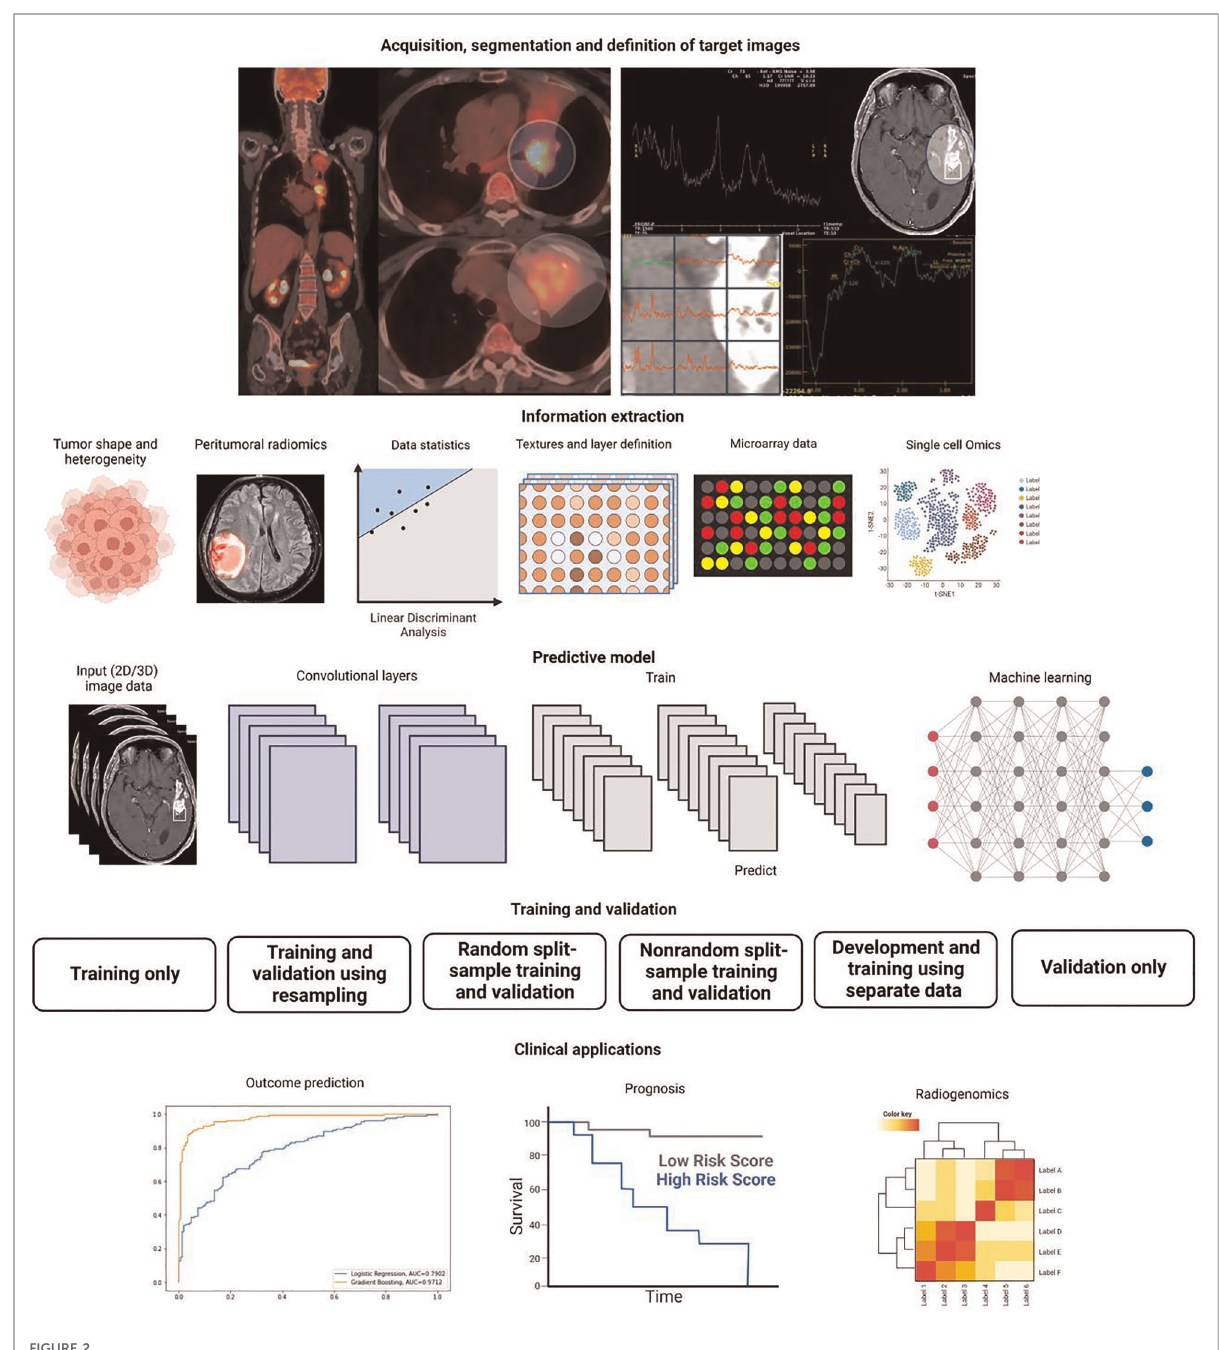
FIGURE 2 Arti fi cial intelligence and